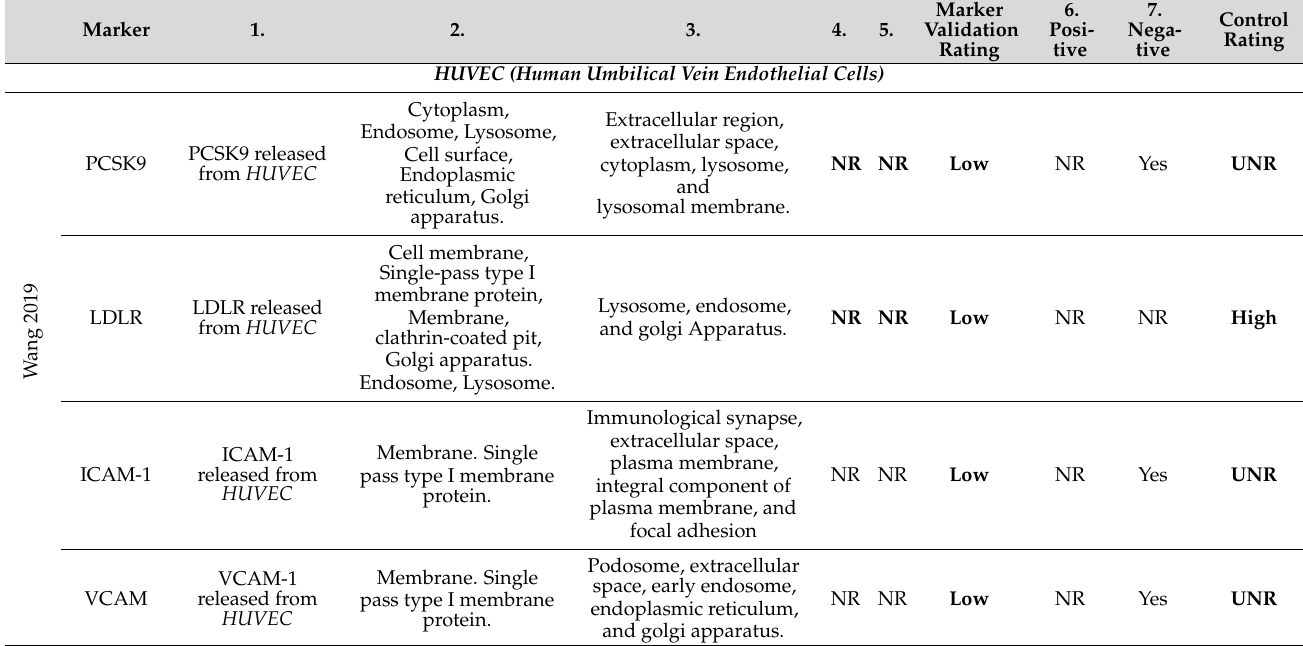
Table A7. Model Validity Tool